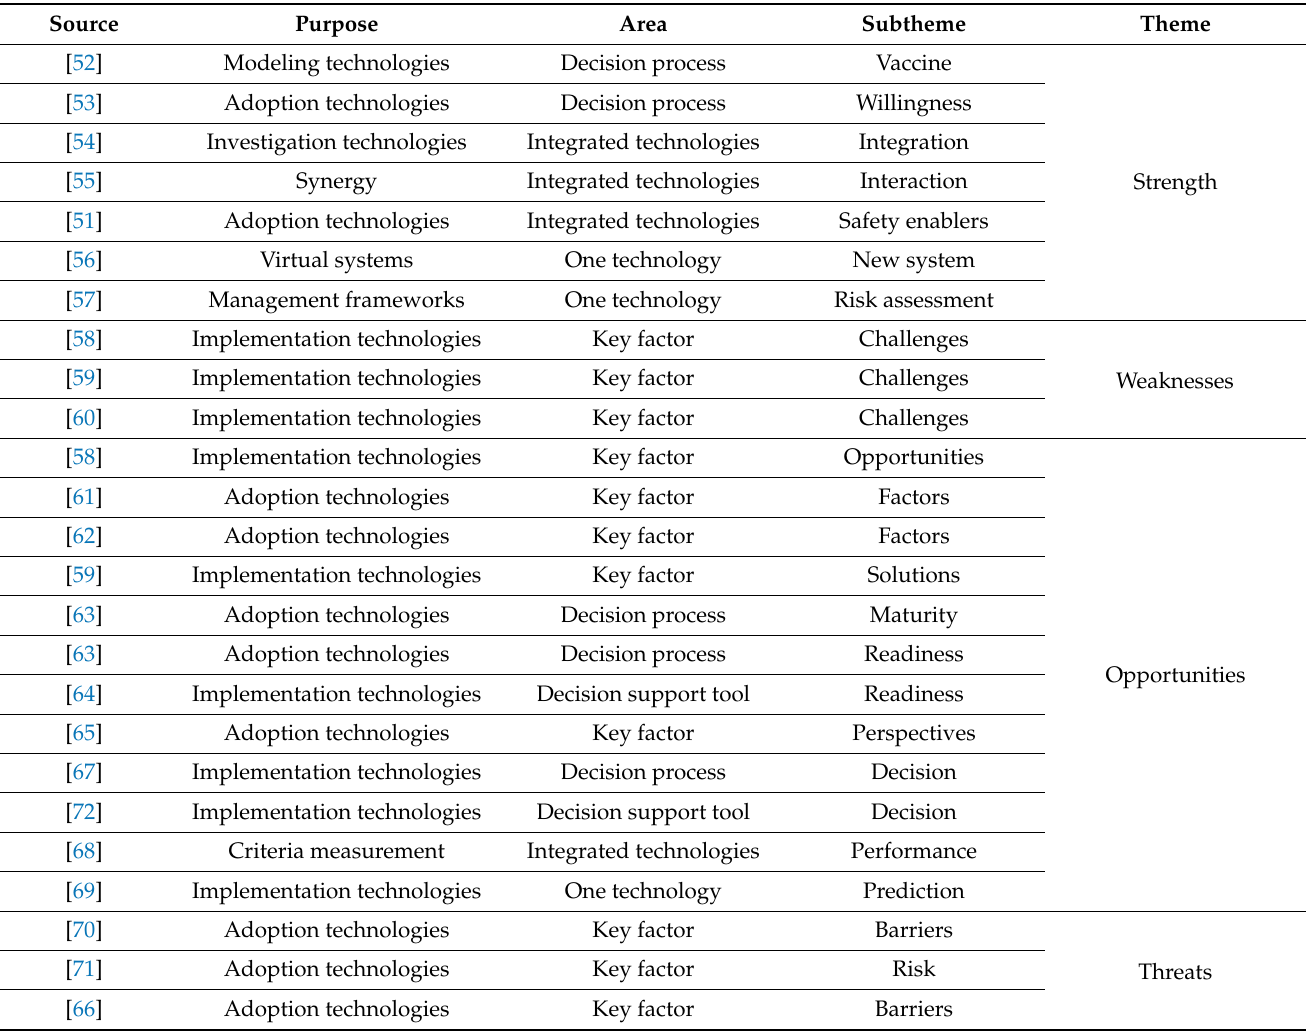
Table 2. Characteristics of the reviewed